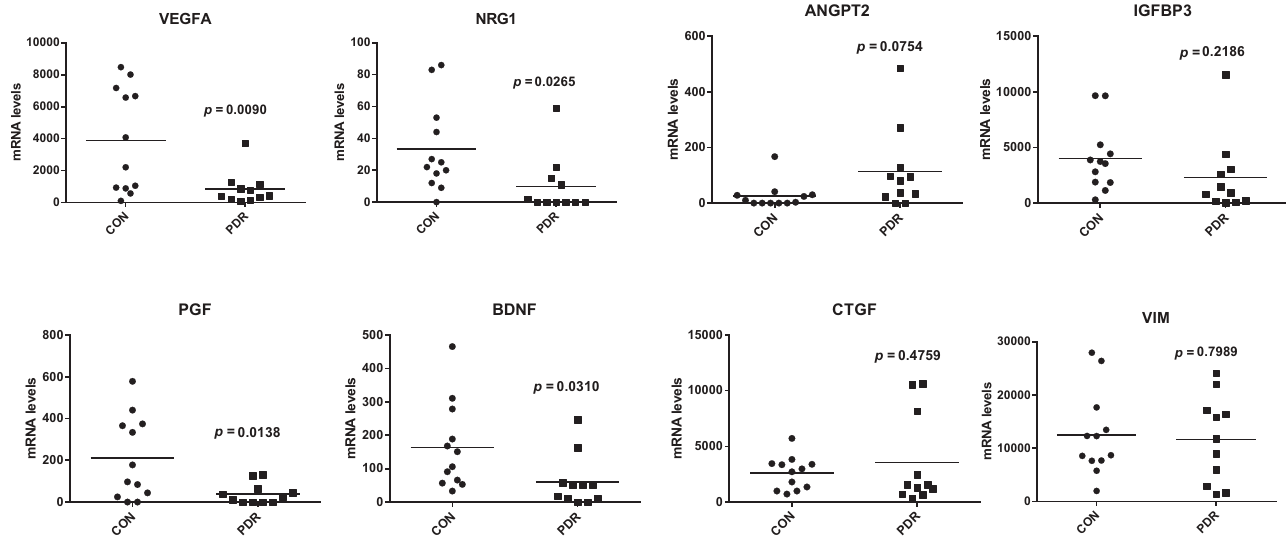
Fig 4. mRNA levels in idiopathic and PDR membranes. Transcript levels of geneswere quantified by real-time quantitative PCR. Differences betweengroups were analyzedby a Student’s t-test. Lines represent mean values.